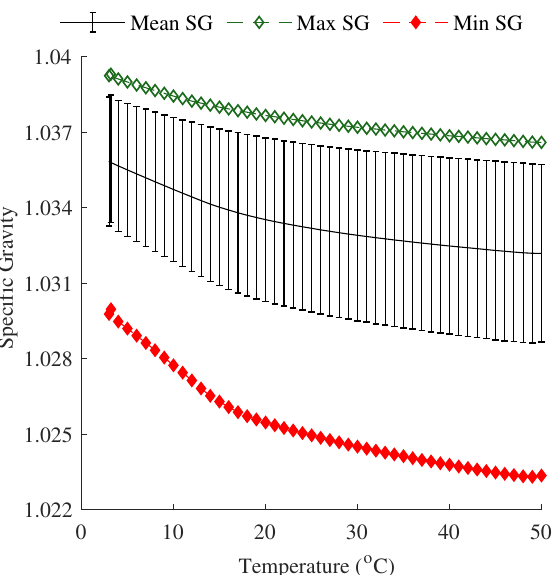
Figure 5. Human milk density response to temperature. Specific gravity (SG) ( ρ milk / ρ water ) shows greater changes in lower temperature range. The maximum and minimum SG values both fall outside the expected standard deviation (SD) range shown in the